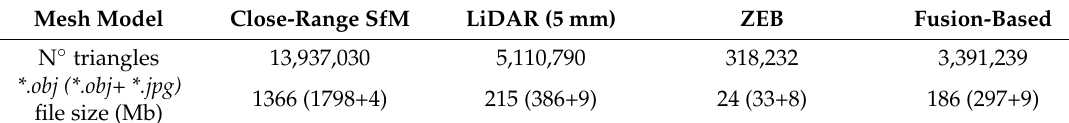
Table 10. Results of mesh triangulation process, based on different sensors point clouds. Mesh Model